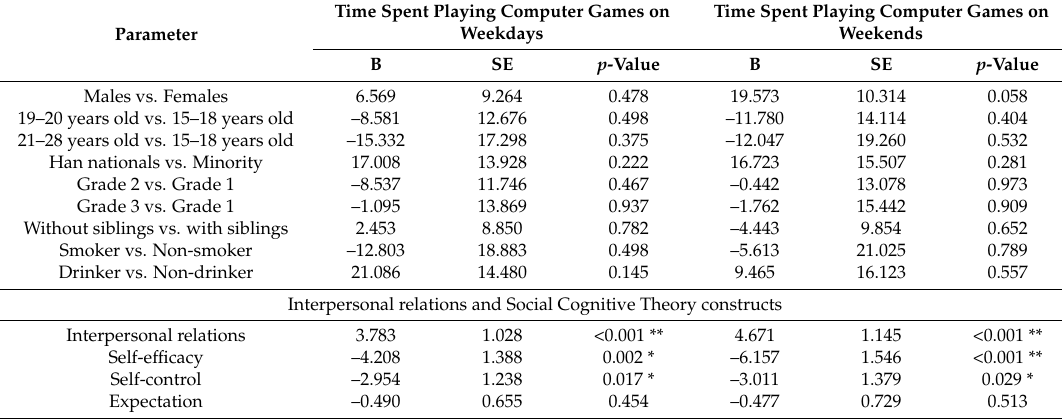
Table 6. Generalised linear model analysis of factors that affect interpersonal relations and social cognitive theory constructs of time spent playing mobile games among all participants in Chongqing, China.